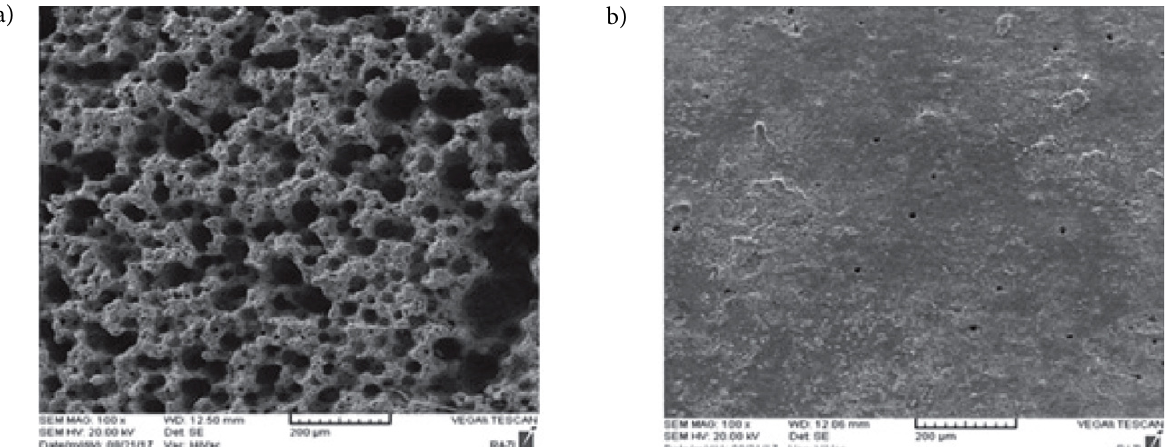
Figure 10. SEM images of mild steel in 0.5 M sulfuric acid solution, a) blank, b) with